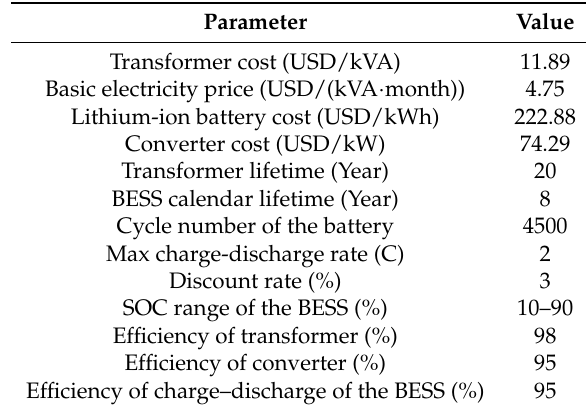
Table 2. Parameter settings for the case.